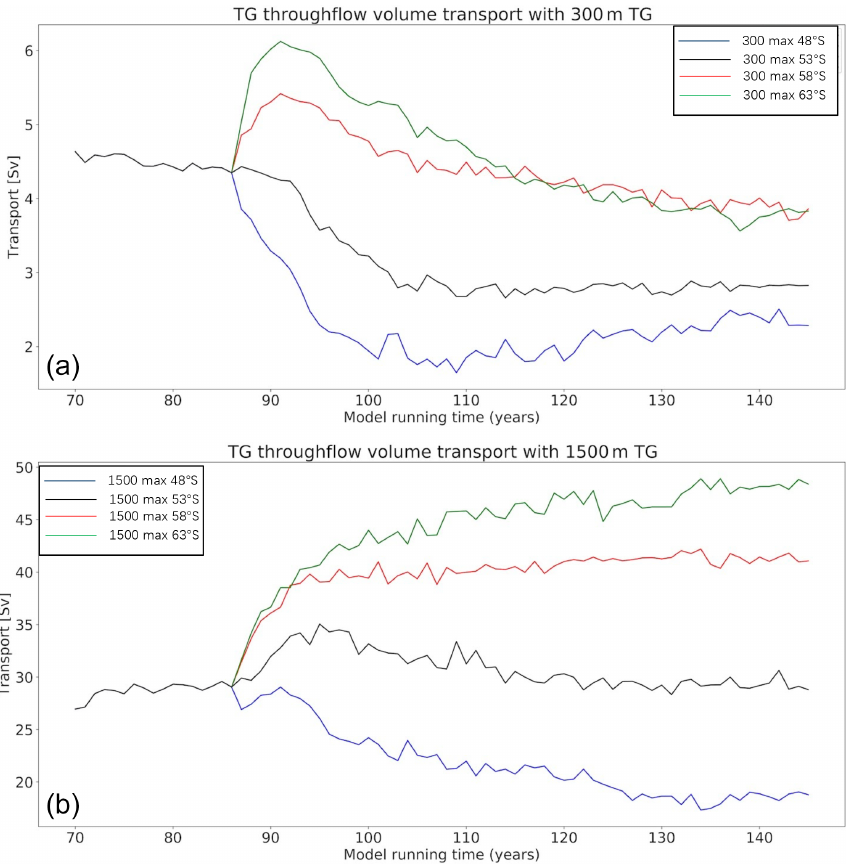
Figure E1. (a) Time series of TG throughflow transport when TG is at 300m. (b) Time series of TG throughflow transport when TG is at 1500m. The period covered by both series is from model year 86 to